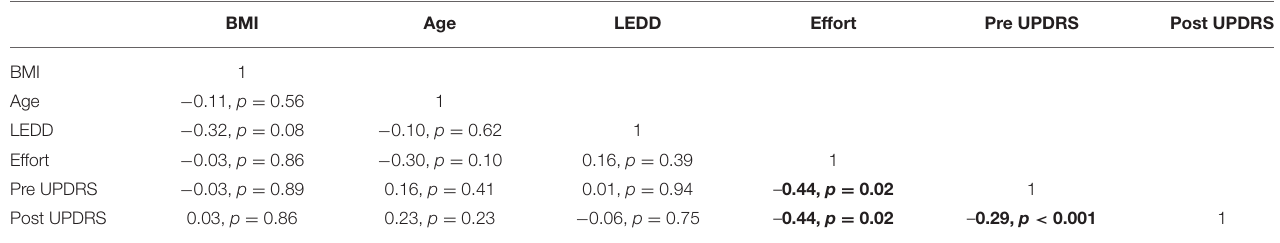
Bolded values are statistically significant. No relationship between gender and effort was